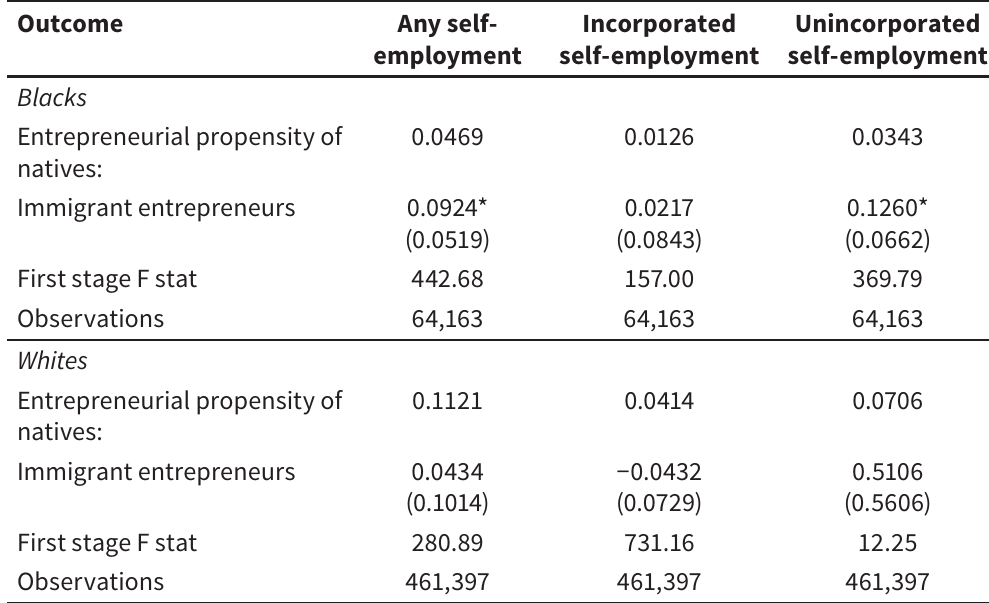
Table 7 Heterogeneity in the impact of immigrant entrepreneurs across races of natives: TSLS